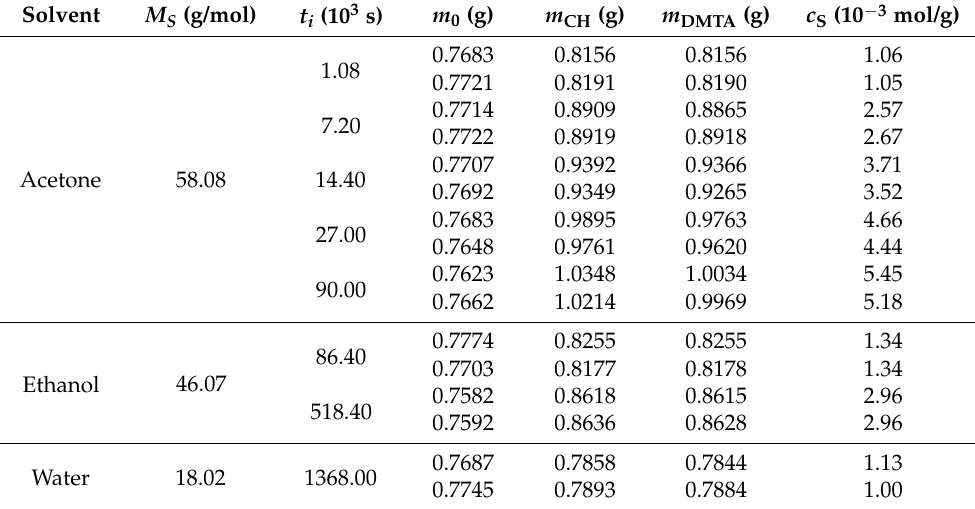
Table 2. Molecular weights of solvents, exposure times, results from weight measurements, and resulting